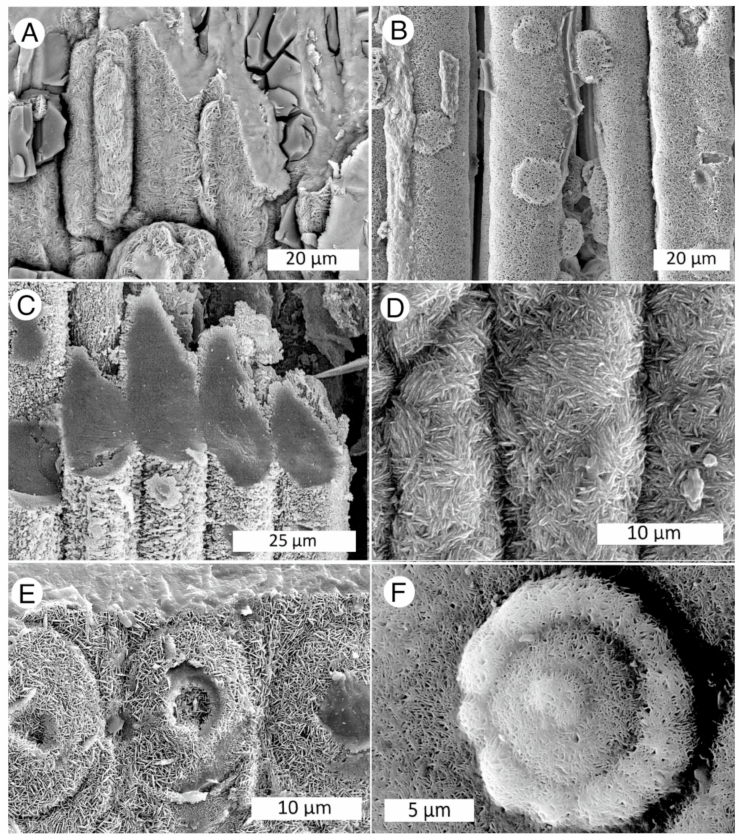
Figure 26. Longitudinal views of Miocene woods mineralized with opal-CT as continuous surfaces. ( A ) Northwest Iran. ( B ) Vantage, Washington, USA. ( C ) Mehrten Formation Sierra Nevada Mountains, California, USA. Note that in this wood the crystal texture is only evident on the exterior surfaces of cell walls. ( D ) Clover Creek, Idaho, USA. ( E ). Conifer wood from Owyee Desert, Oregon, USA showing preservation of bordered pits. ( F ) Single bordered pit, Middlegate, Nevada,